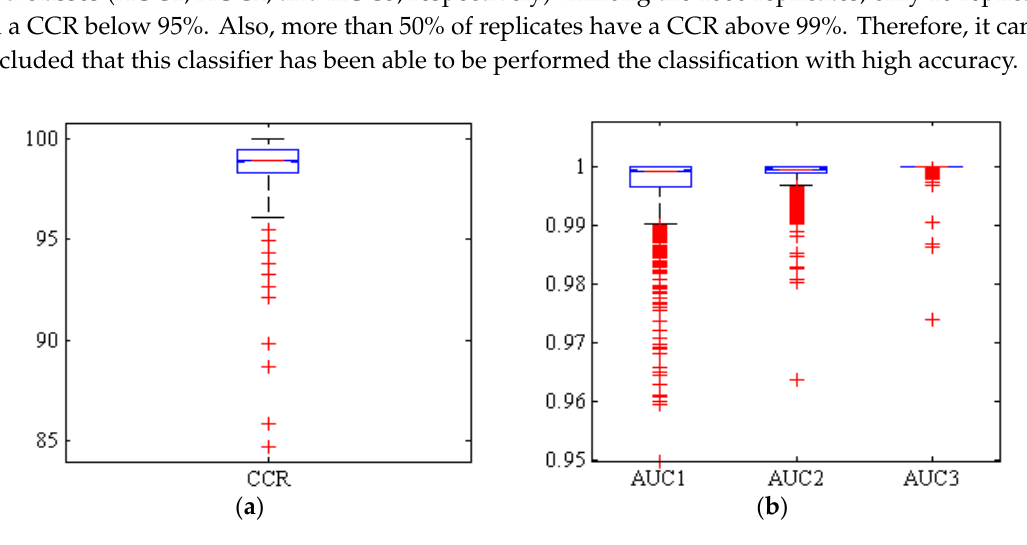
Figure 5. Boxplots of ( a ): the correct classification rate (CCR) and ( b ): area under the ROC curve (AUC) by hybrid ANN-PSO classifier, for Adel (AUC1), Arman (AUC2), and Azad (AUC3) chickpea ( Cicer arietinum L.) varieties (1000 uniform random iterations, test set).